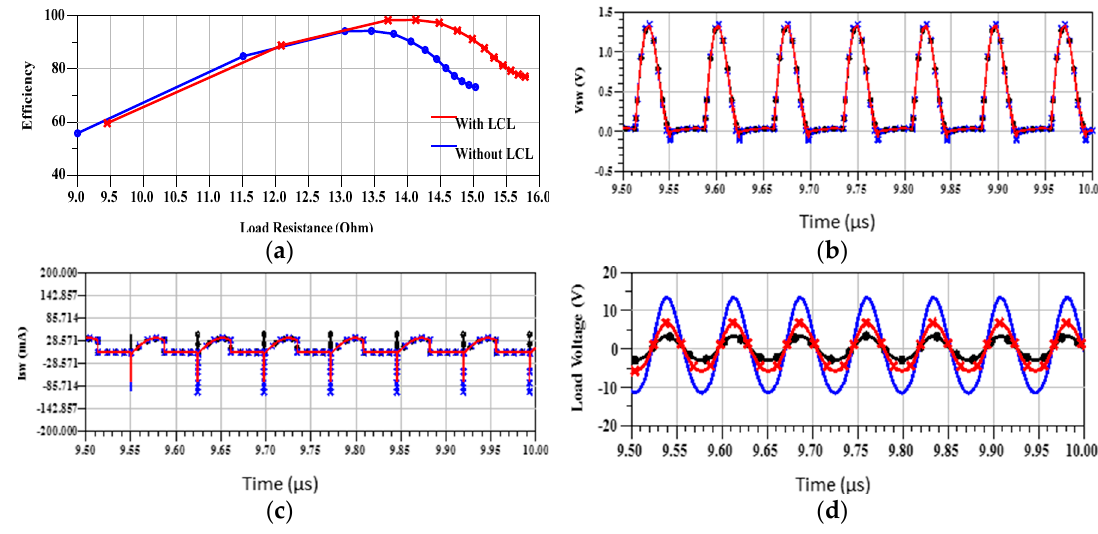
Figure 14. PA load variations variation R L = 13.5 Ω (blue line), R L = 16 Ω (red line), R L = 21 Ω (black line): ( a ) η versus R L ; ( b ) V sw versus R L ; ( c ) I sw versus R L and ( d ) load